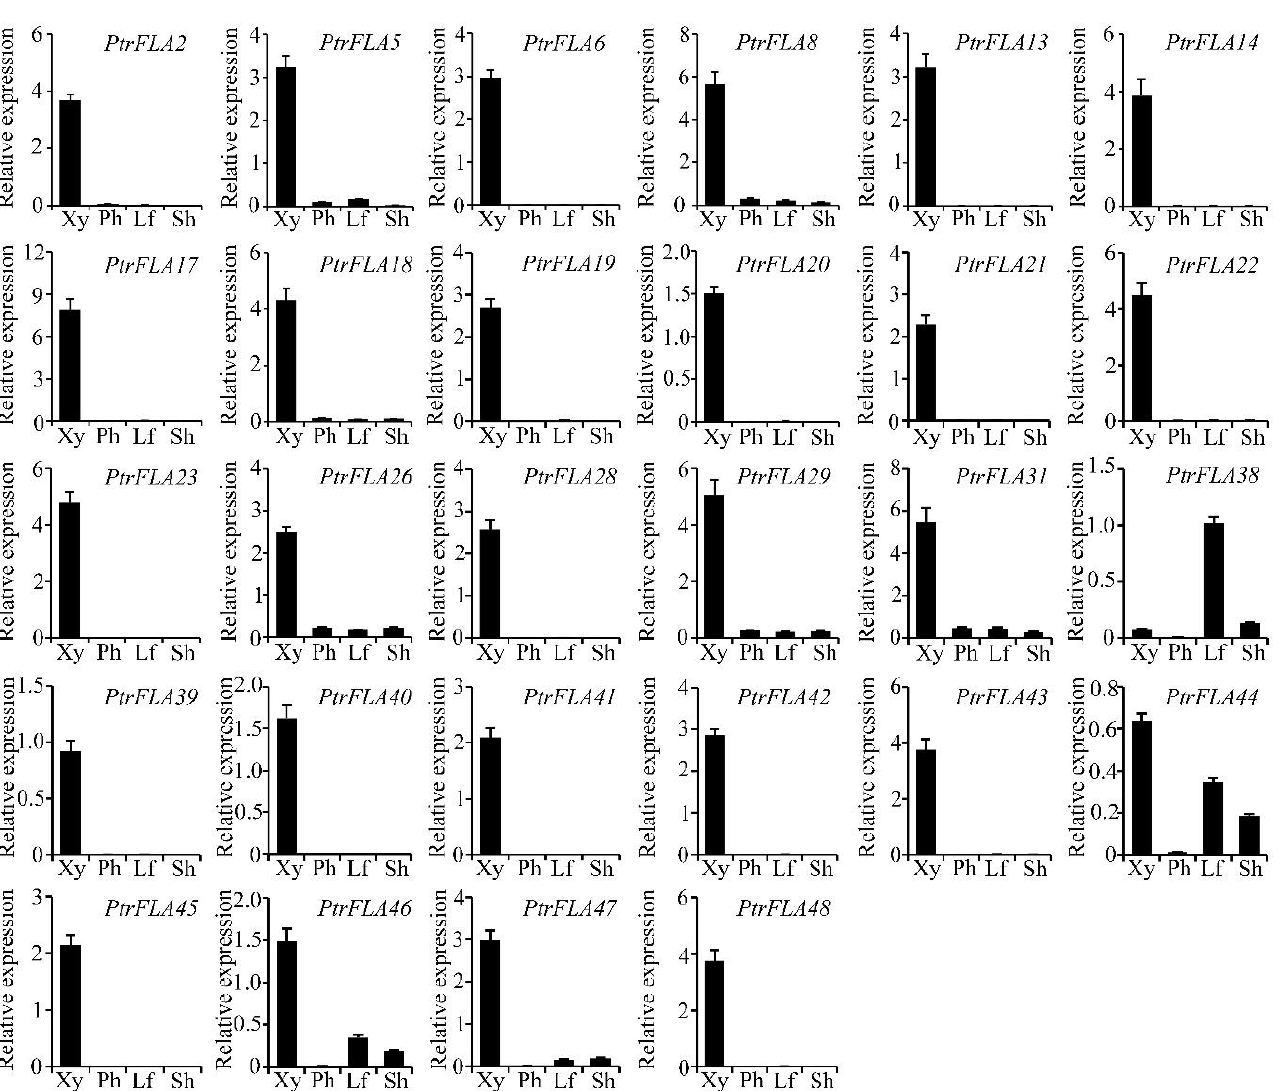
Figure 2. Expression profile of the group A FLAs in P. trichocarpa using RT-qPCR. Different tissues included developing xylem, phloem, leaf, and shoot. The expression of PtActin2 was used as an internal control. Xy, xylem; Ph, phloem; Lf, leaf; Sh, shoot.